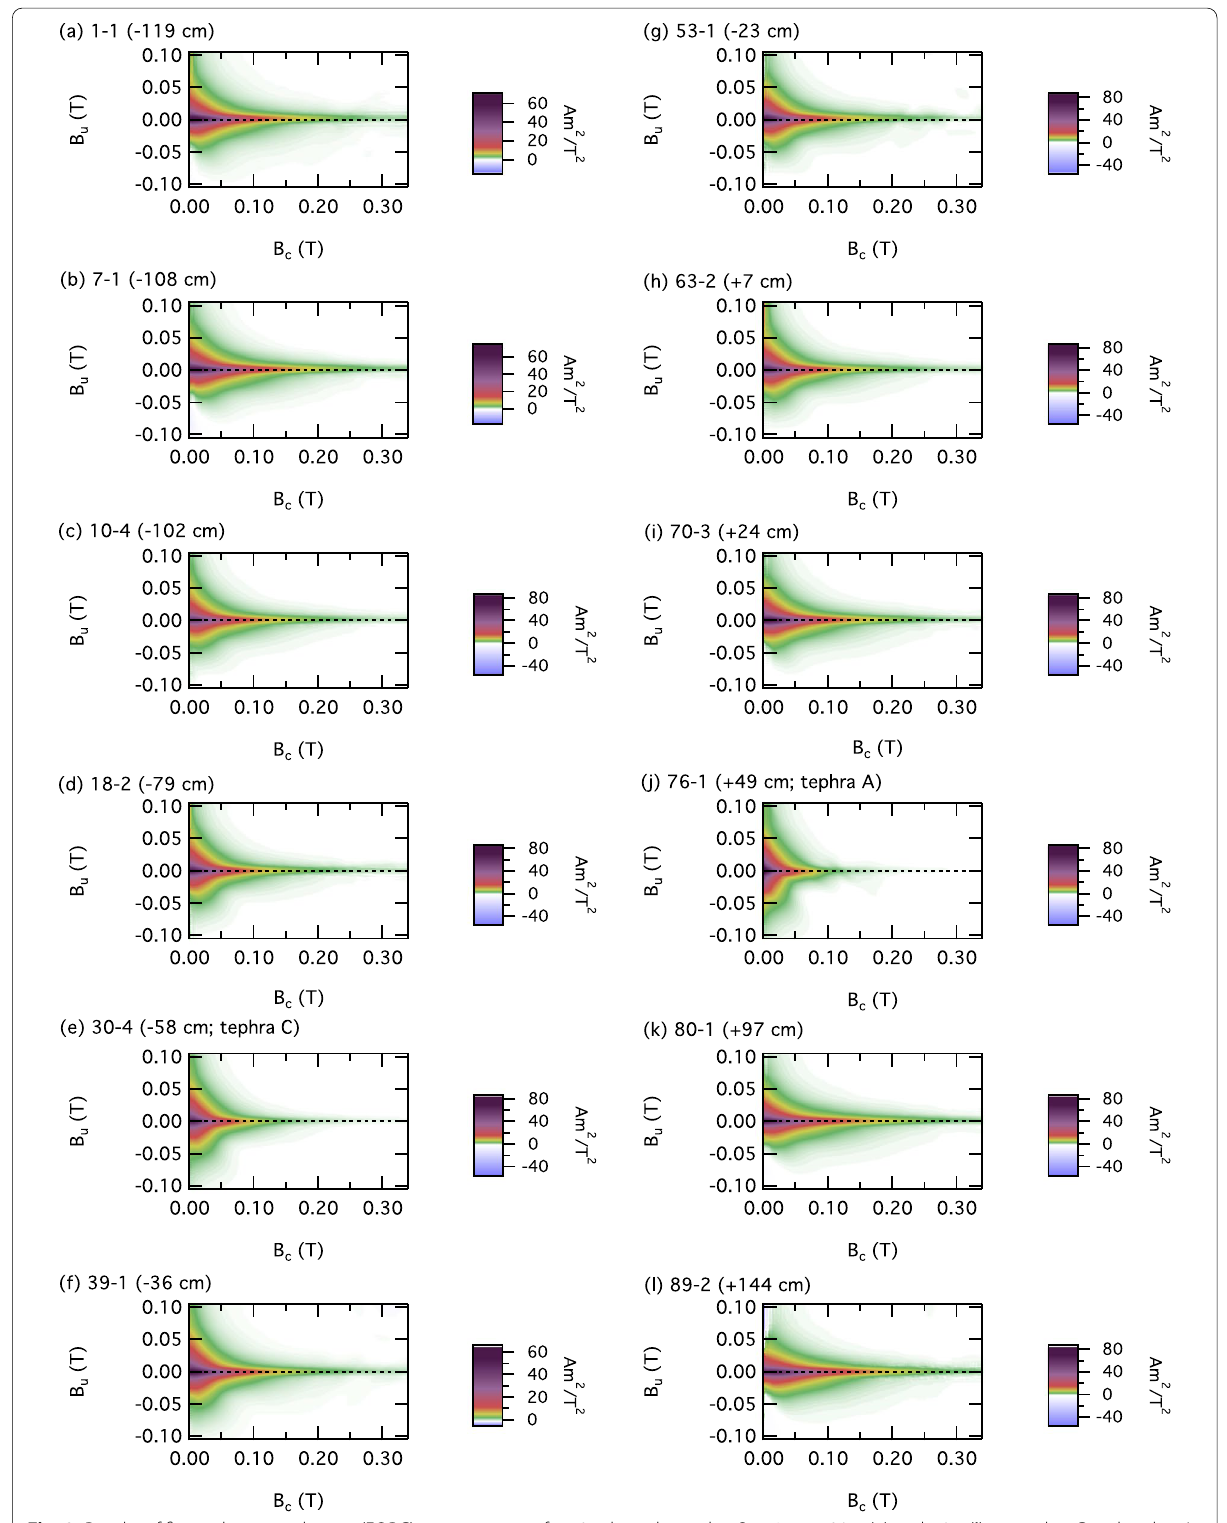
Fig. 8 Results of first order reversal curve (FORC) measurements for 12 selected samples. Specimens 30-4 ( e ) and 76-1 ( j ) are tephra C and tephra A,